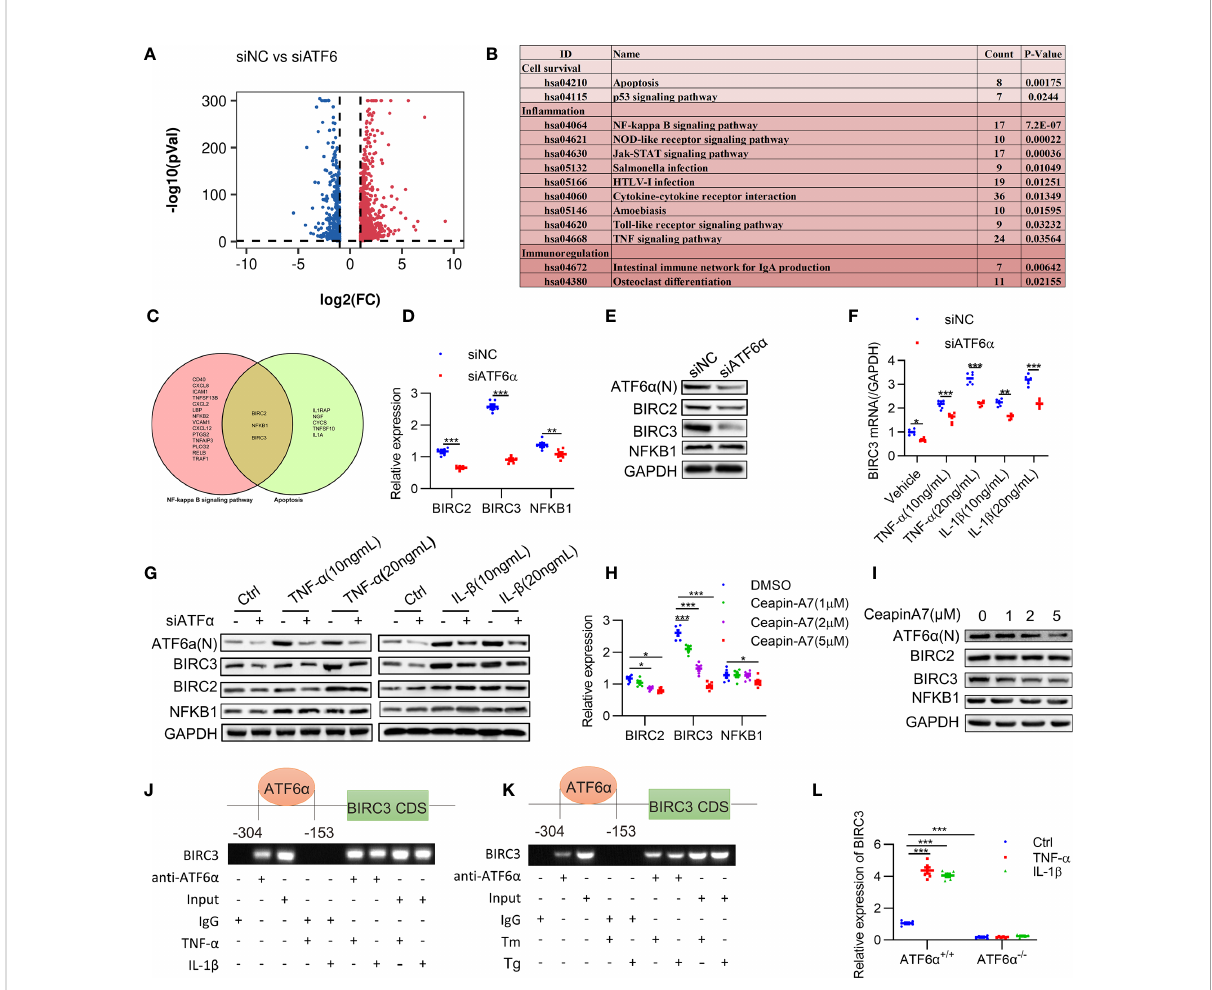
FIGURE 5 Identi fi cation of BIRC3 as the target gene of ATF6 a . (A) , Volcano plot of differentially expressed genes (DEGs) upon ATF6 a knockdown as derived from RNASeq. (B) , KEGG enrichment analysis of DEGs was performed, and representative pathways (P<0.05) were listed. (C) , Venn diagram of genes of NF-kappa B signaling pathway and apoptosis pathway. (D – H) , RA FLSs were transfected with ATF6 a -siRNA for 72 h (D, E) , followed by treatment with TNF- a or IL-1 b for another 24 h (F, G) . RA FLSs were treated with ceapin-A7 (0, 1, 2, or 5 m M) for 24 h. BIRC2, BIRC3 or NFKB1 expression was analyzed by qPCR (D, F, H) and Western blot (E, G, I) . (J, K) , RA FLSs were treated with TNF- a (10 ng/mL), IL-1 b (10 ng/ mL), Tm (2 m g/mL), or Tg (300 nM) for 6 h. ChIP analysis was performed. (L) MEF cells isolated from ATF6 a +/+ and ATF6 a -/- mice were treated with the vehicle (Ctrl), TNF- a (10 ng/mL), or IL-1 b (10 ng/mL) for 24 h. BIRC3 expression was measured by qPCR. Data were expressed as mean ± SD ( n = 6) and analyzed using two-way ANOVA. n represent biologically independent samples (D, F, H, L) . * P <0.05, ** P <0.01, *** P <0.001. ATF6 a (N): N-terminal fragment of ATF6 a ; Tm: tunicamycin; Tg: